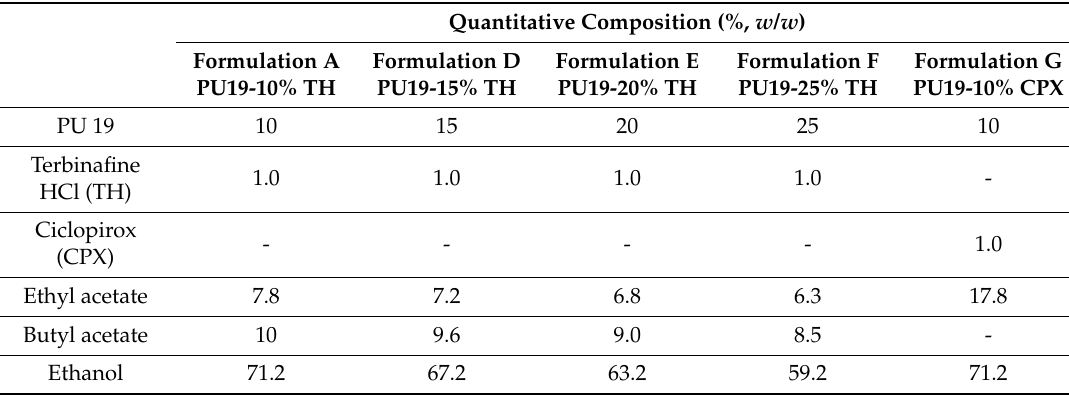
Table 1. Qualitative and quantitative composition of nail lacquers (%, w/w